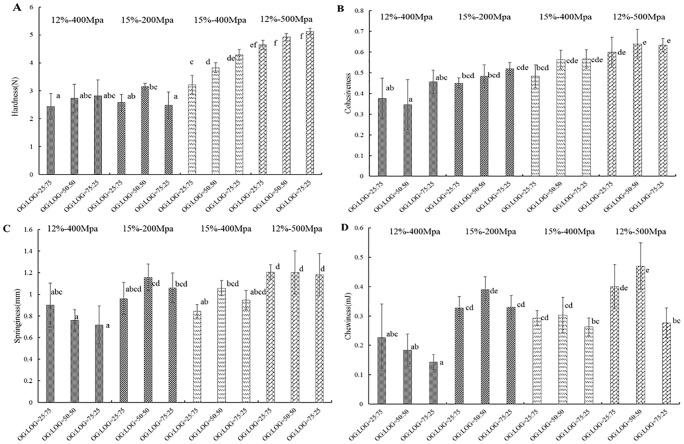
Textural property of the β-glucan mixed gels prepared at different pressure with varying total concentrations and ratios.(A) The hardness of the β-glucan mixed gels. (B) The cohesiveness of the β-glucan mixed gels. (C) The springiness of the β-glucan mixed gels. (D) the chewiness of the β-glucan mixed gels. Different superscript letters indicate significant differences in the same graph (p < 0.05).